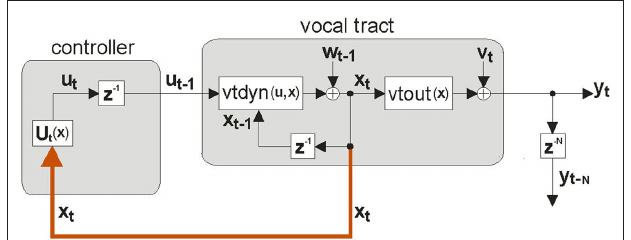
. If the CNS had had t vtout x  ( ) ˆ t ), it could send to the internal t − 1